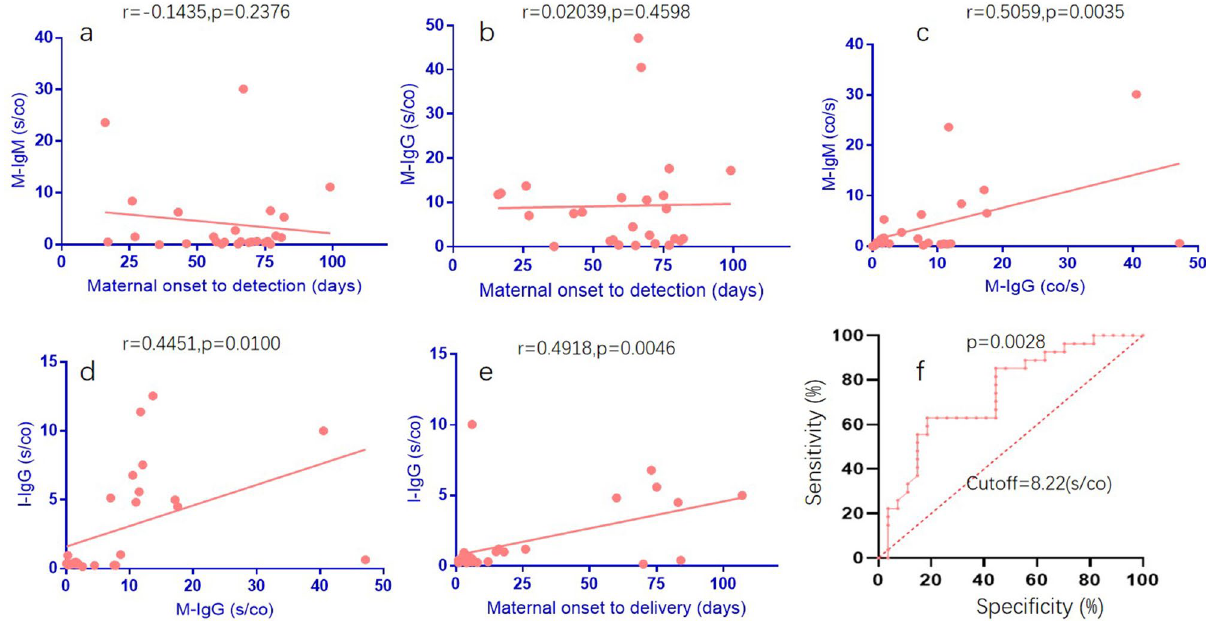
Figure 1. Dynamic characteristics of serum antibodies in pregnant women and infants. ( a ) Correlation between maternal infection time and serum IgM titer in pregnant women (M-IgM); ( b ) Correlation between maternal infection time and serum IgG titer in pregnant women (M-IgG); ( c ) correlation between the maternal serum IgG and IgM titer in pregnant women; ( d ) correlation between maternal serum IgG and infant IgG titer (I-IgG); ( e ) correlation between the maternal infection time before delivery and the IgG titer of infants; ( f ) predicting the sensitivity and specificity of maternal antibodies transferring into infants. Pearson test was used to analyze the correlation between the two groups, P < 0.05 was considered to be statistically